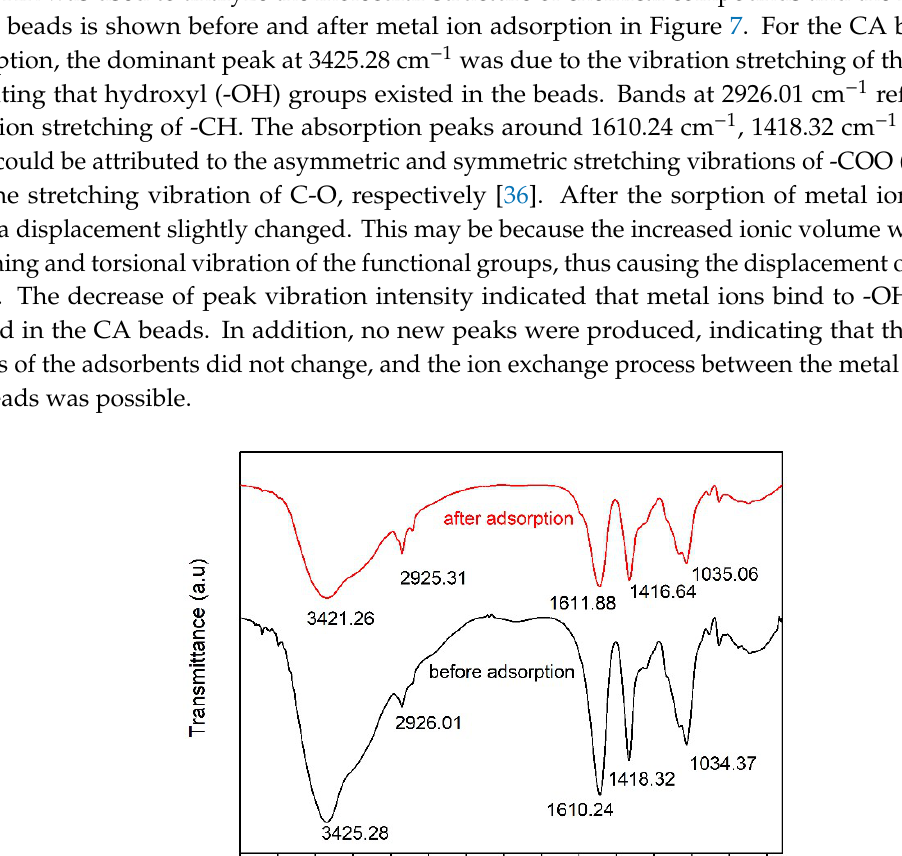
Figure 8. X-ray photoelectron spectroscopy (XPS) spectra of CA beads after the adsorption of mixed metal ions at a concentration of 500 mg/L in aqueous solution. Cu(II) preferentially bound to the active sites of CA beads when the four ions were coexistent at the same concentration (Figure 9). The selective adsorption mechanism of copper ions on CA beads was via divalent metal ions exchanging ions with Ca(II) in the “egg box” structure [41]. The adsorption sites were mainly negative groups (COO-) that could adsorb the cation in the solution, and the stability of the bond with Cu(II) was better [42]. Therefore, compared with Zn(II), Ni(II) and Cd(II), the affinity for Cu(II) was the strongest in the ion exchange process between Ca(II) and metal ions in CA beads. This competitive relationship made the CA bead a potential material that could be applied to the recovery the copper ions from heavy metal mixtures.